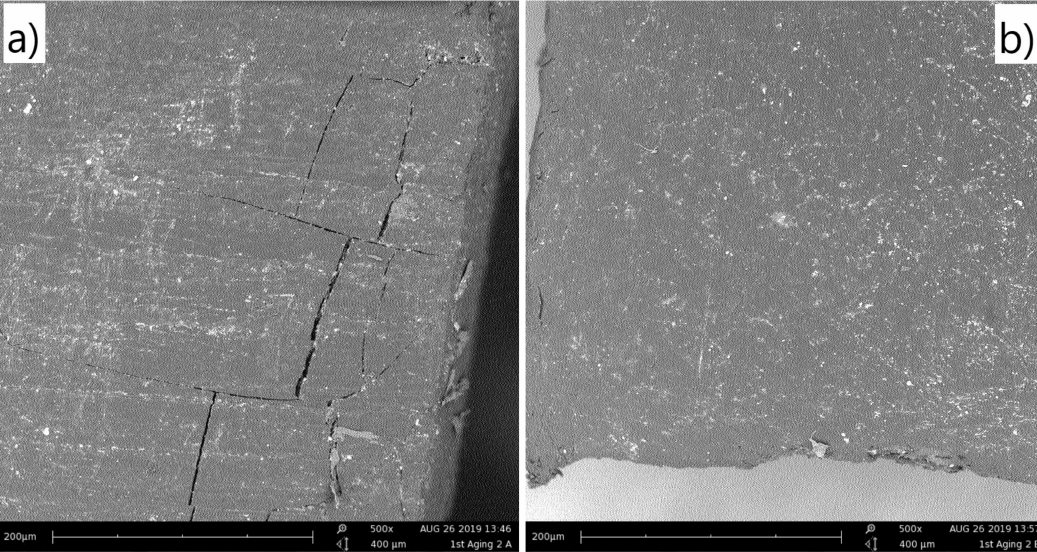
Figure 6. SEM images of the sample type ABS 2 (entry 3 in Table 1) after the 1st aging step. ( a ) UV exposed side and ( b ) unexposed